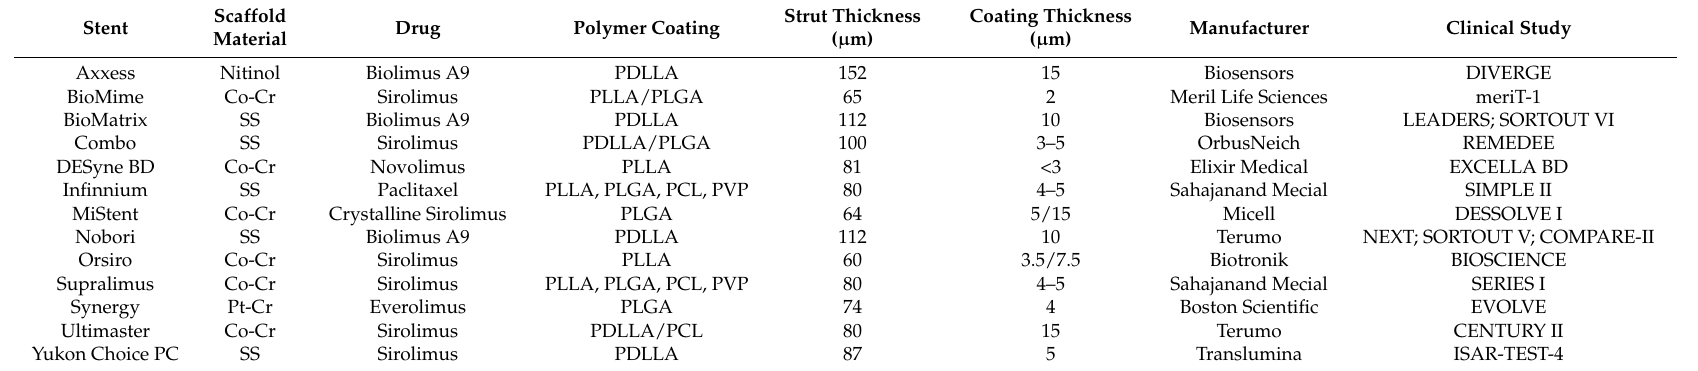
Table 1. Summary of partially bioresorbable coronary